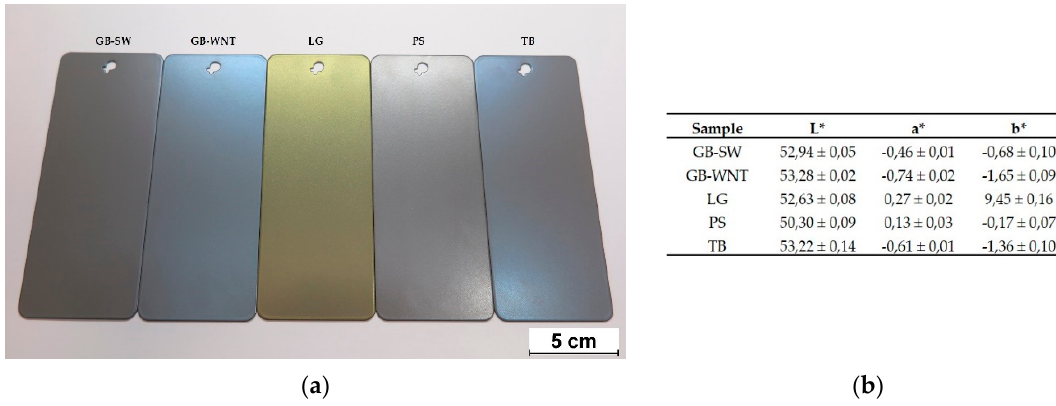
Figure 4. ( a ) Photography of the as-prepared samples; ( b ) Samples’ colorimetric coordinates according to CIE L * a * b